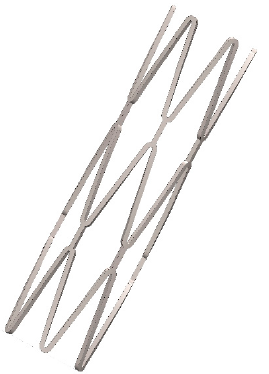
Figure 1. Initial cylindrical configuration of spherical occlusion device.